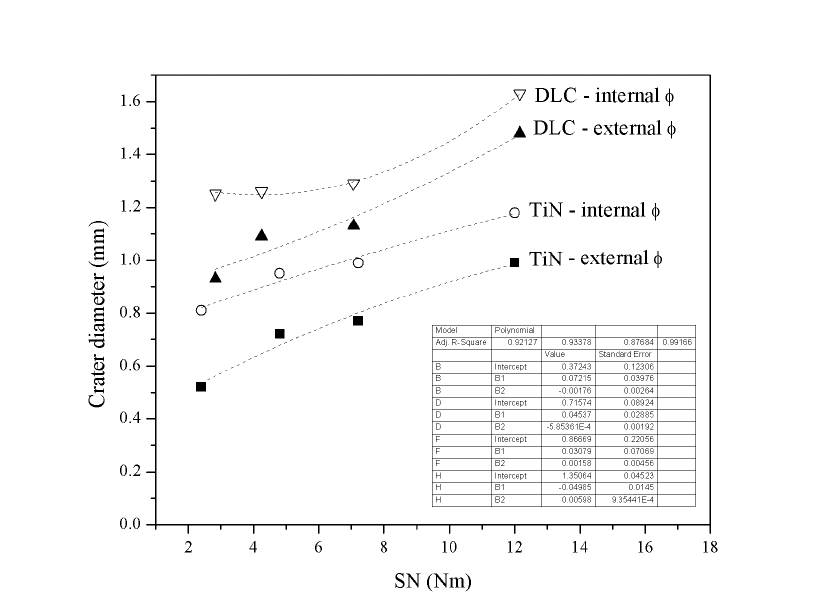
Figure 10. Experimental data obtained from ball-cratering tests on TiN and DLC coated sample with mean values of the internal and external crater